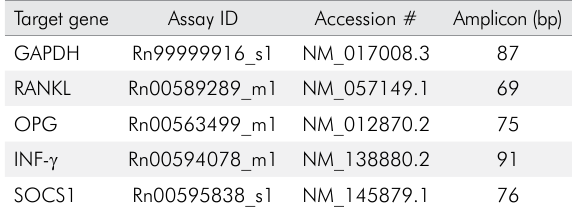
Table. Inventoried TaqMan primers and probe (TaqMan Gene Expression Assays, Applied Biosystems). Target